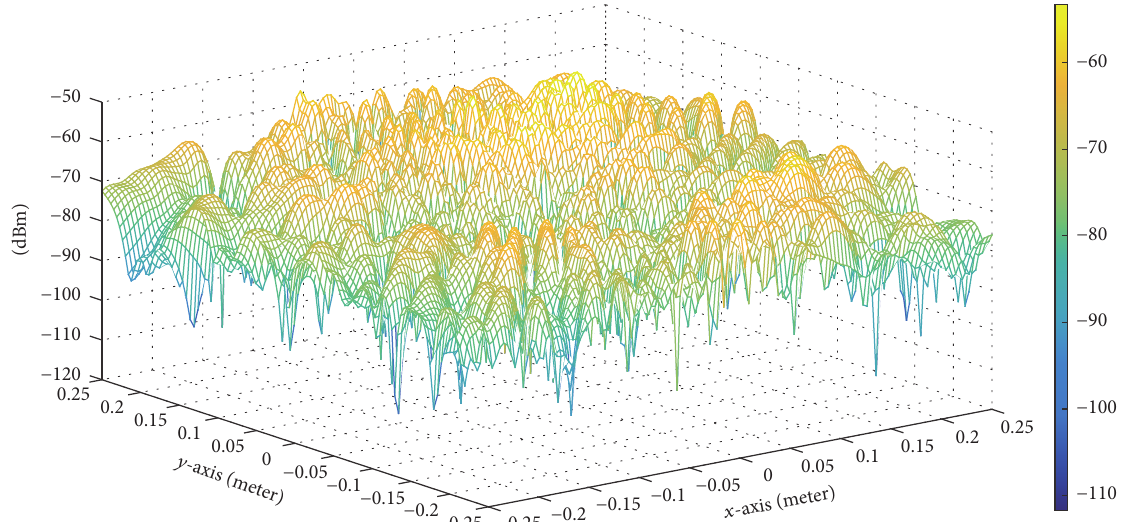
Figure 13: The power distribution of the contrast function, showing the reflected power over measurement domain after applying MRL algorithm.